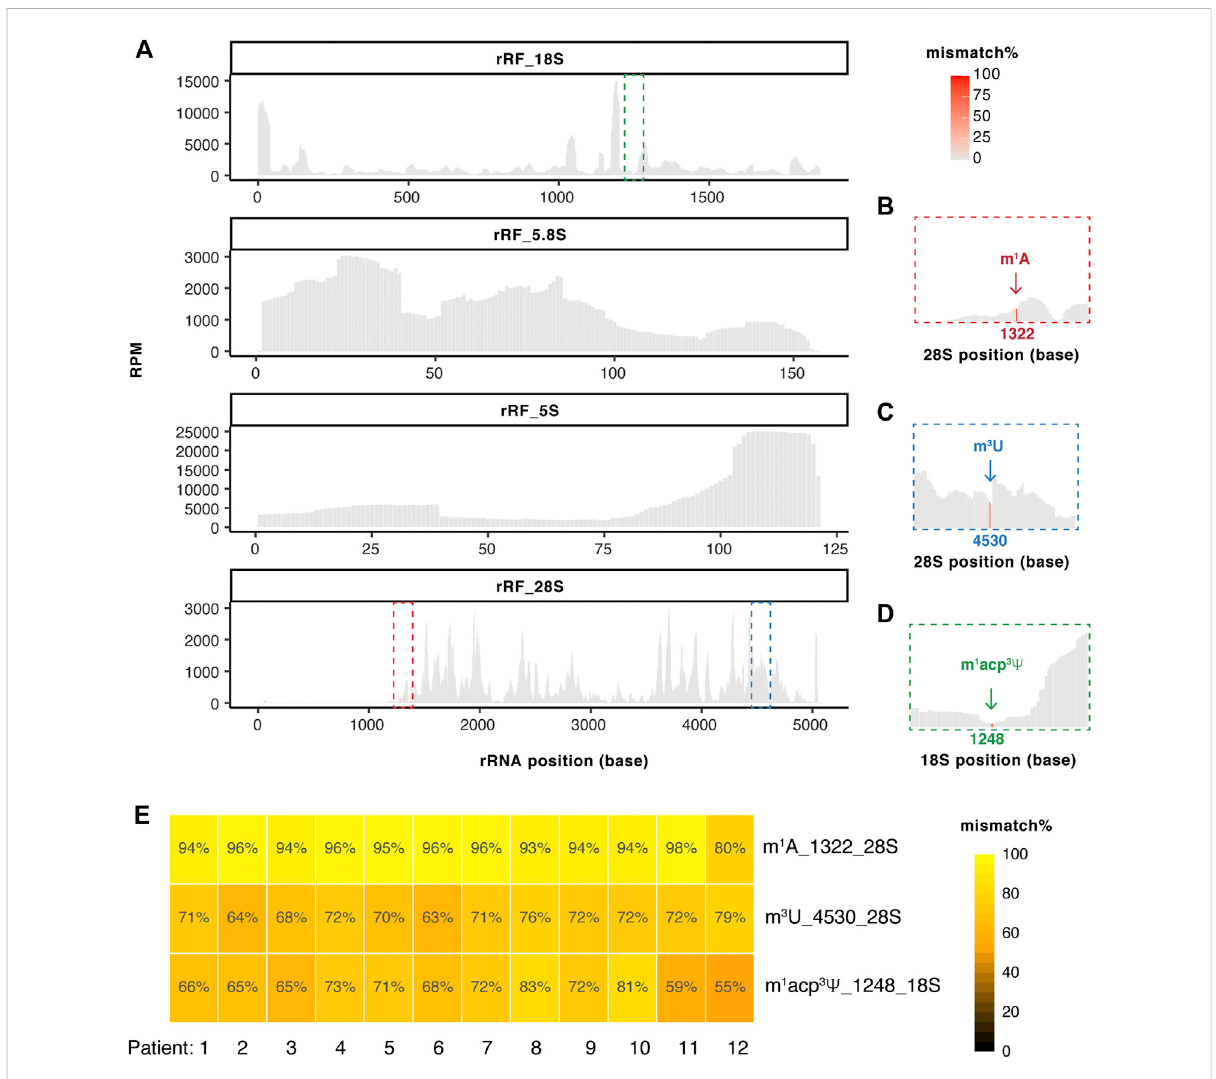
FIGURE 5 TGIRT-seq detects abundant rRFs with overall low mismatch rate and high mismatch at speci fi c positions. (A) Example coverage plot of rRFs mapped on each rRNA sequences with mismatch highlighted at each position (patient #2 shown as example). Coverage plots for all 12 samples are showninSupplementaryFiguresS5 – 8.Squaredboxesarefurtherzoomedinpanel (B) toshowhighmismatchpositions. (B – D) Highmismatchat (B) position 1322 on 28S rRNA (C) position 4530 on 28SrRNA and (D) position 1248 on 18S rRNA are highlighted. (E) Patient-to-Patient variation of the mismatch% at the three high mismatch positions on rRFs (B – D)